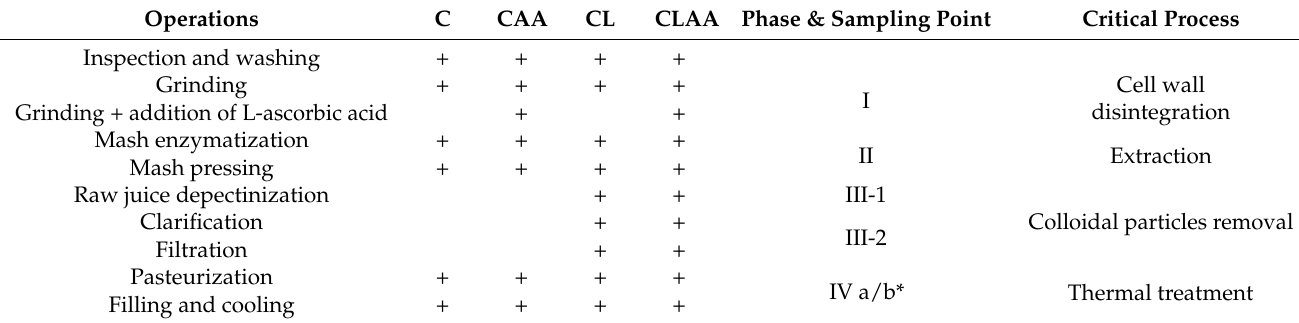
Table 4. Operations during the apple juices